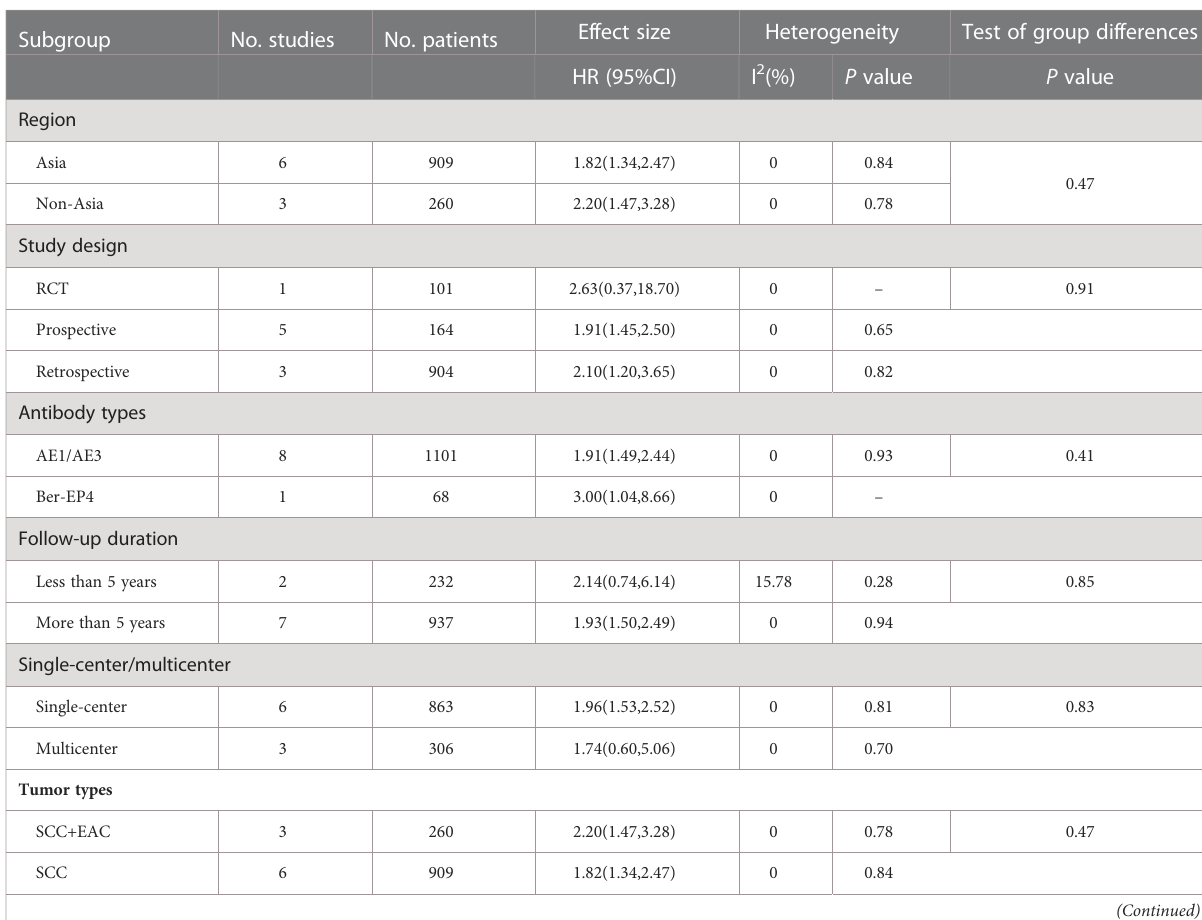
TABLE 2 Subgroup analysis of clinical